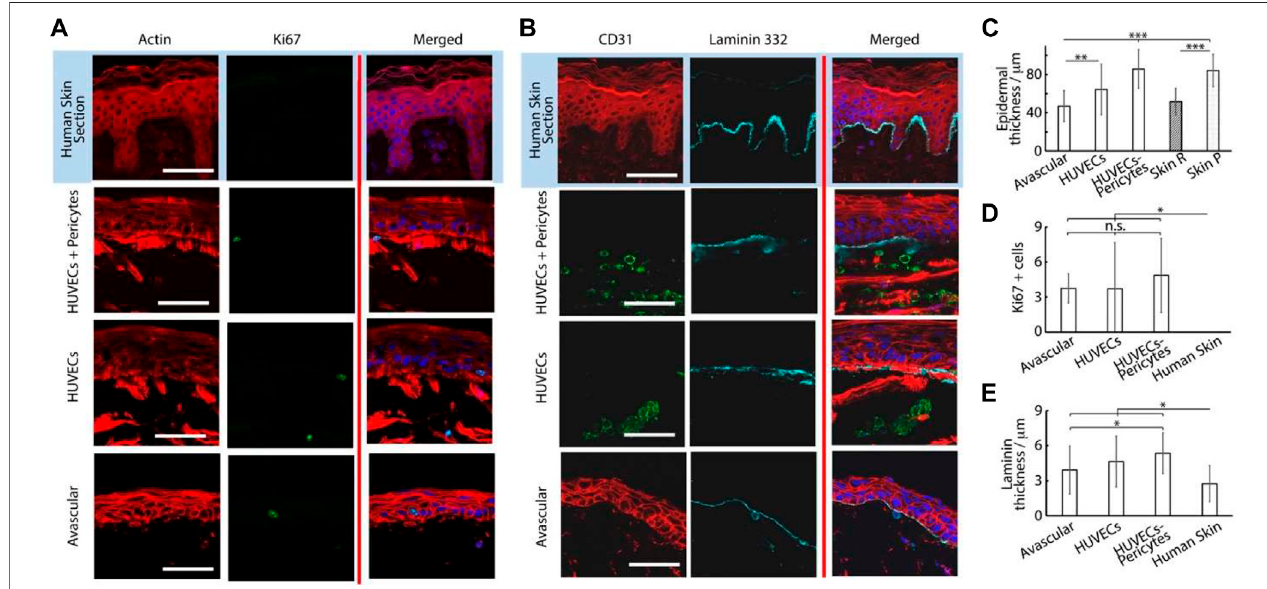
FIGURE 5 | Histology sections of microvascularized skin-on-chip constructs and human skin sections immuno-stained with phalloidin (red), DAPI (blue), and for Ki67, (A) green or CD31 and laminin 332 and (B) green and cyan, respectively. Tissues were cultured for 14 days in submerged conditions. Scale bars: 50 μ m. (C) Quanti fi cation of the corresponding epidermal thickness, density of Ki67+ cells (D) and thickness of laminin 332 (E) . * p < 0.05; ** p < 0.01; *** p < 0.001; n.s., non- signi fi cant, p > 0.05; error bars are standard errors; n = 3.